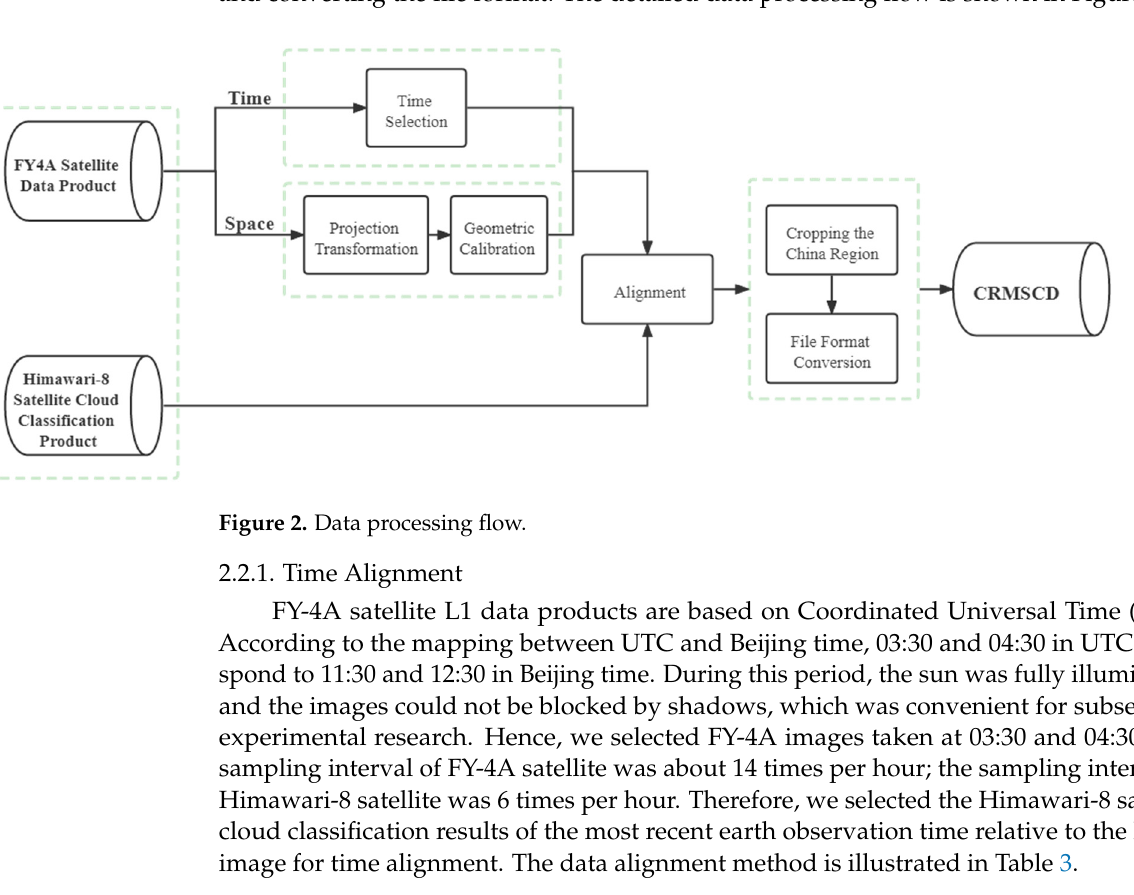
Figure 1. Location of the study area.